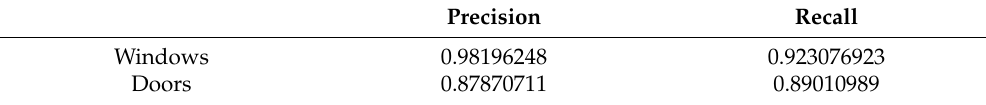
Table 3. Results of the fully automated detection process for window and door symbols.